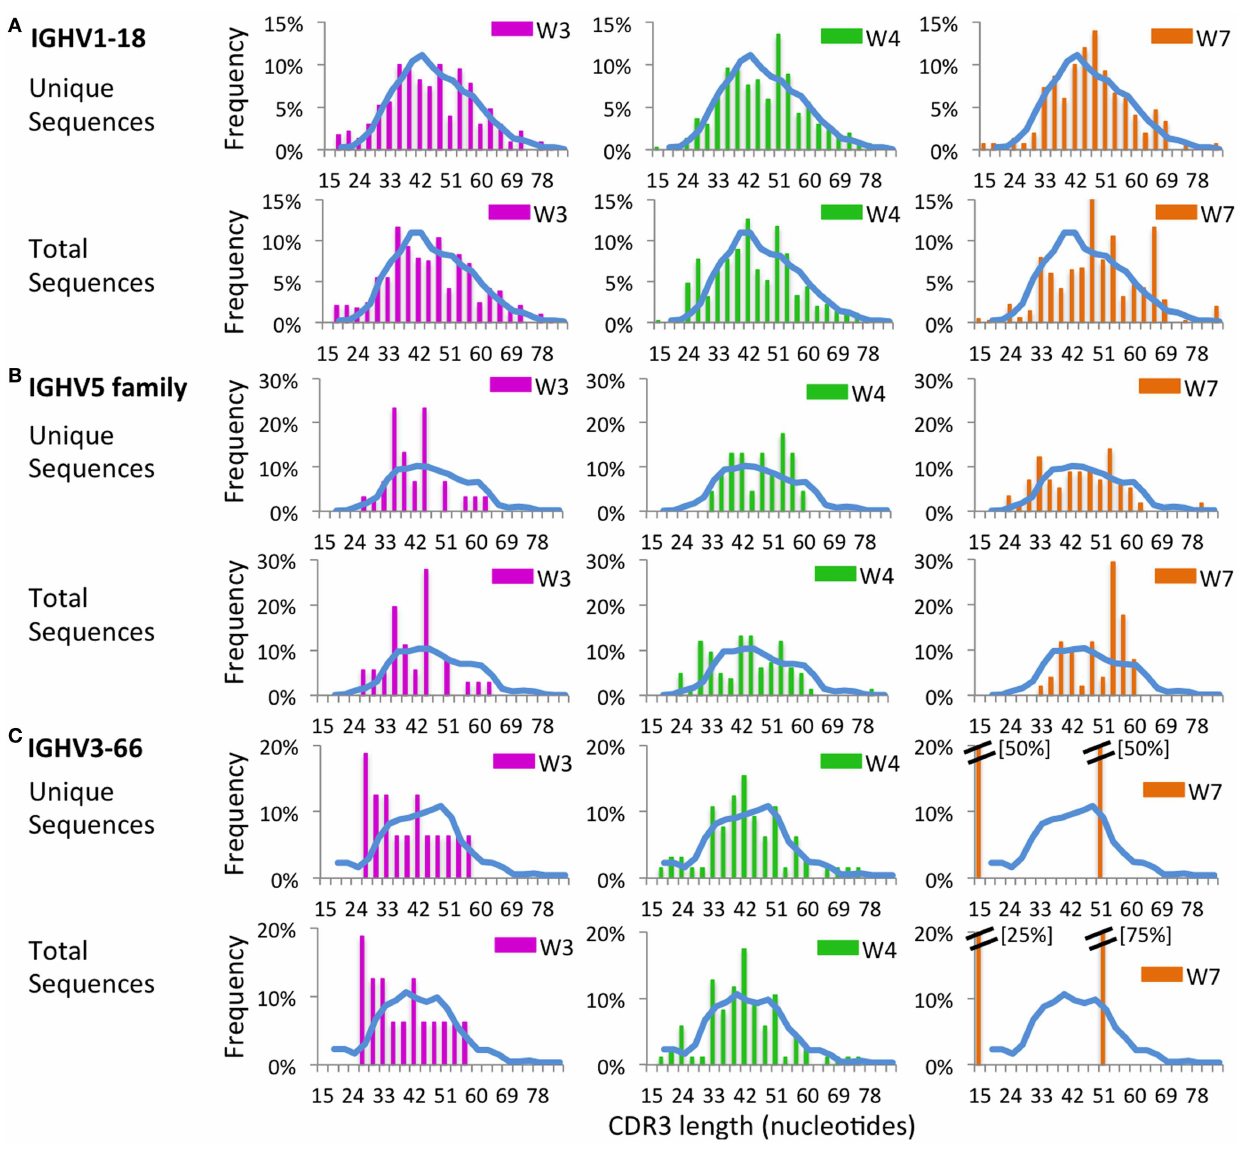
FIGURE 12 | Complementarity determining region 3 length analysis of IGHV subgroups . CDR3 length analysis was performed on CD19 + cells expressing IGHV1-18 (A) , IGHV5 (B) , or IGHV3-66 (C) .The mean distribution